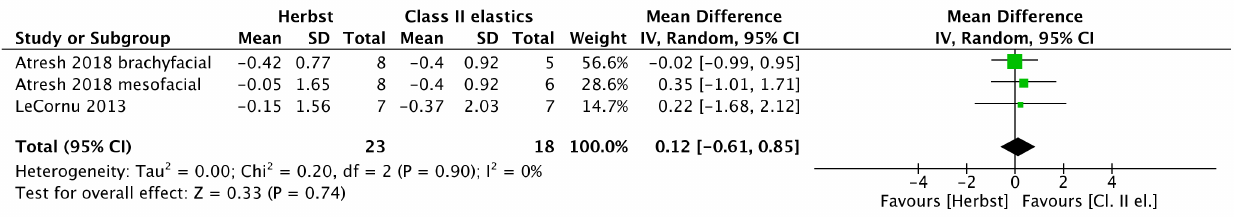
Figure 13. Forest plot of the left gonial angle changes using the random effects model